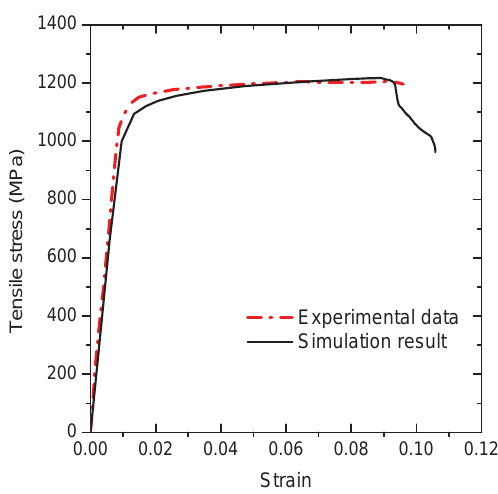
Figure 5. The engineering stress–strain curve of the RVE under uniaxial tension based on the fitted input stress–strain curves for the grain boundary α layer and the grain interiors.